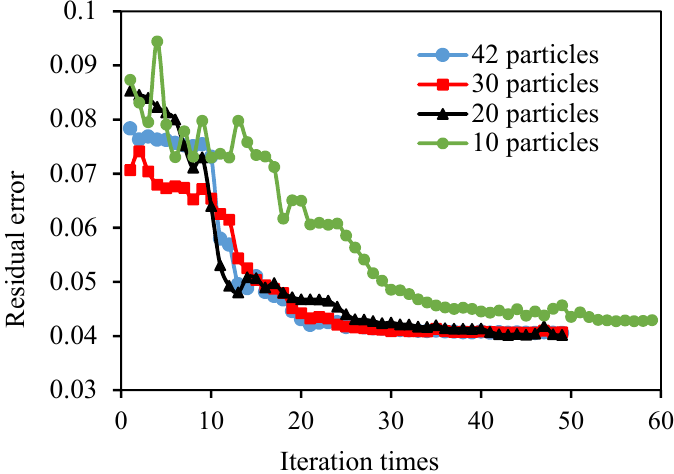
Figure 11. Residual error evolution for standard PSO with different particle numbers.